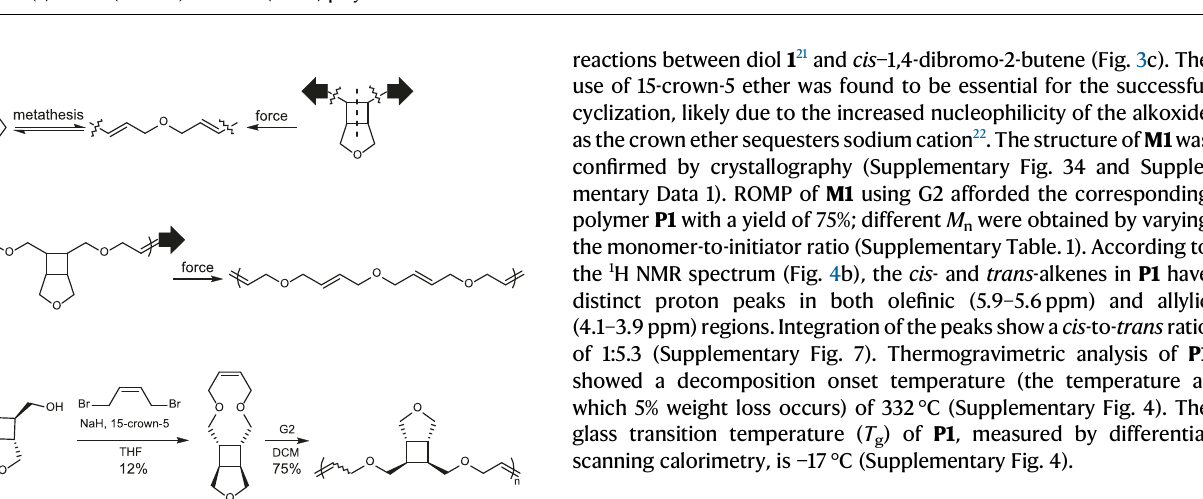
Fig.2|Revisitingthesynthesisofpoly(2,5-dihydrofuran).a Ringstrainenergies(RSE)ofmonomersrelevantto2,5-dihydrofuran(DHF). b , c Partial 1 HNMRforDHF( b ) and DHF dimer ( c ) before (in black) and after (in red) polymerization.